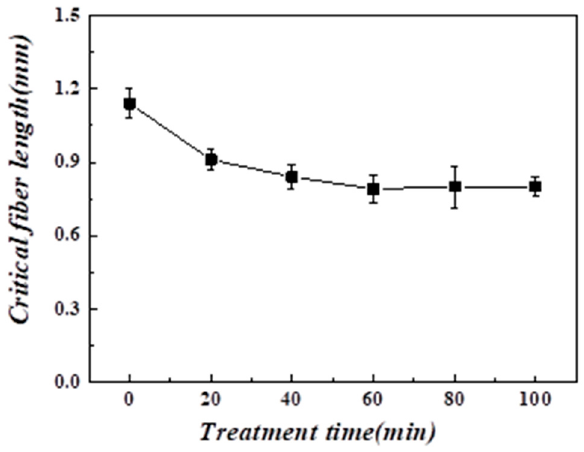
Figure 14. Effect of the acid treatment time on the critical fiber length of the stainless-steel fibers